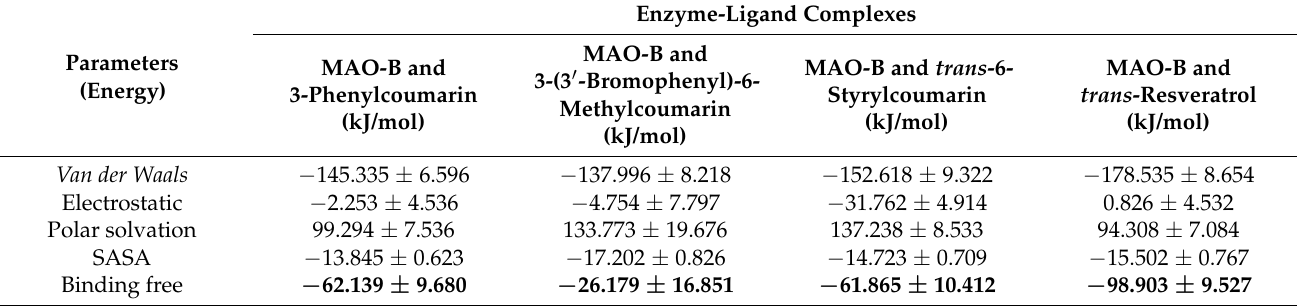
Table 4. MM-PBSA binding free energies of MAO-B with 3-phenylcoumarin, 3-(3 (cid:48) -bromophenyl)-6- methylcoumarin, trans -6-styrylcoumarin and trans -resveratrol between 80 ns and 100